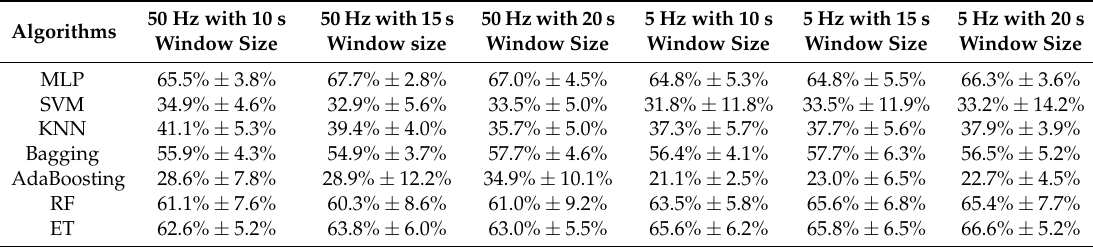
Table 4. Cross-validation accuracy and standard deviation for the classification algorithms trained for longer window